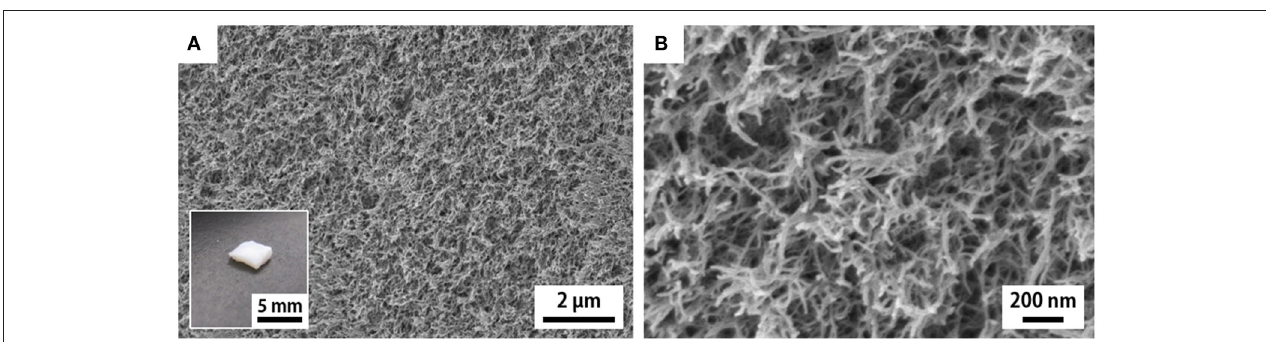
FIGURE 4 | SEM images of the cross section of the h - Al -xerogel. (A,B) show the images taken at low and high magnifications, respectively. Inset shows appearance of the h - Al -xerogel.